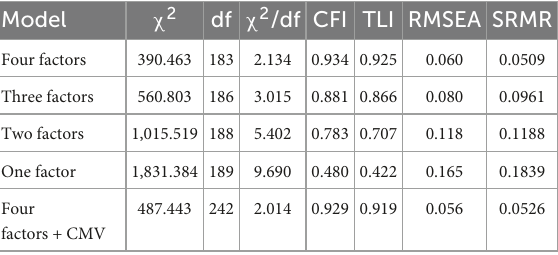
TABLE 3 Results for confirmatory factor